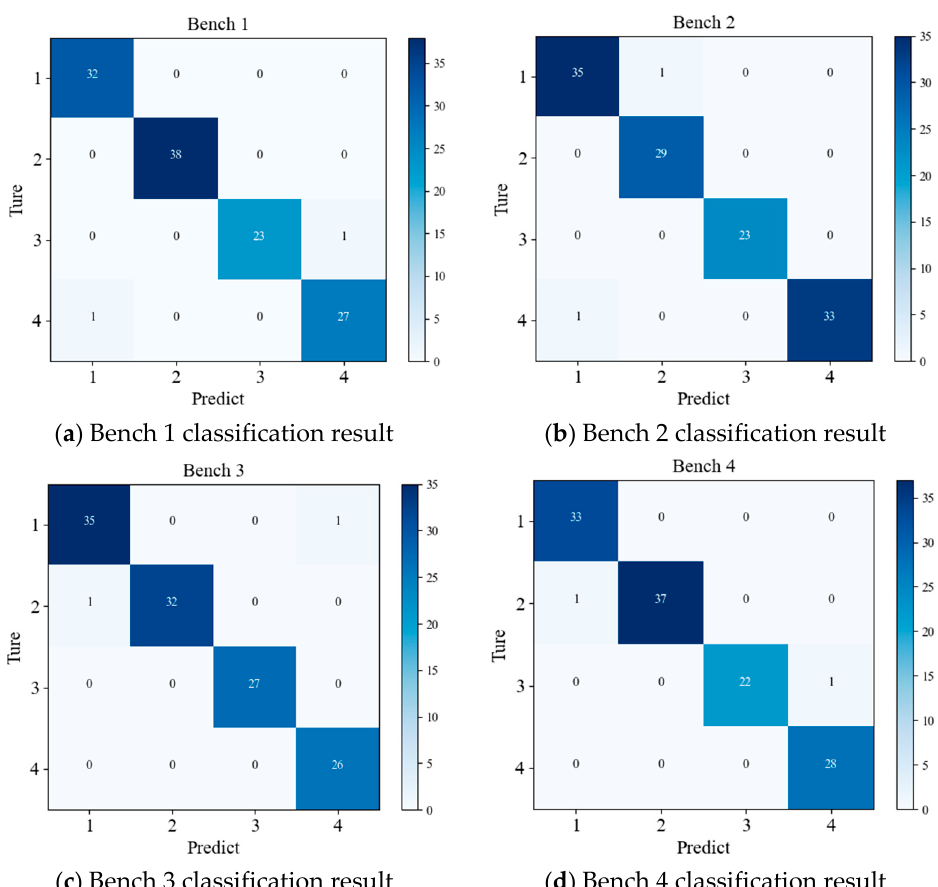
Figure 12. Confusion matrix of 4 kinds of benches under the proposed method.